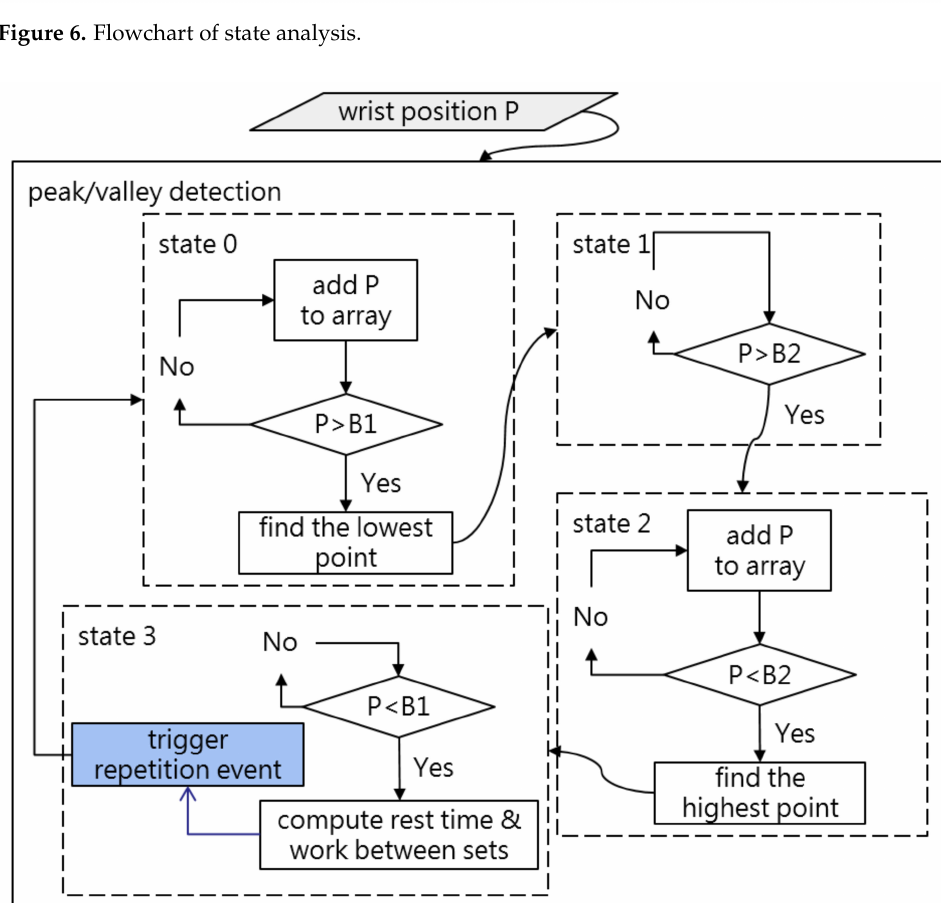
Figure 7. Peak/valley detection